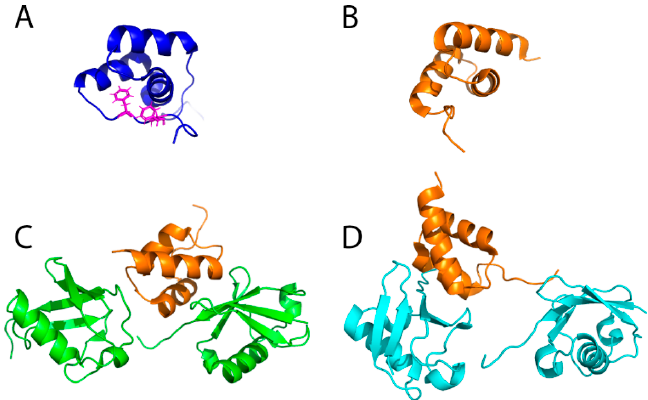
Figure 3. Structural comparison of CUE domains and their binding to di-ubiquitin. ( A ) NMR structure of the CUE domain of Cue1 (PDB ID: 2MYX). Phenylalanine residues that are crucial for the stability are shown with side chains; ( B ) NMR structure of the CUE domain of gp78 (PDB ID: 2LVN); ( C ) NMR structure of the CUE domain of gp78 bound to the distal moiety in a K48-linked di-ubiquitin (PDB ID: 2LVP). Orange and green colors represent the CUE domain and di-ubiquitin, respectively; ( D ) NMR structure of the CUE domain of gp78 bound to the proximal moiety in a K48-linked di-ubiquitin (PDB ID: 2LVQ). Orange and cyan colors represent the CUE domain and di-ubiquitin, respectively. The structures involving the gp78 CUE domain and di-ubiquitin show the dynamic interaction between both